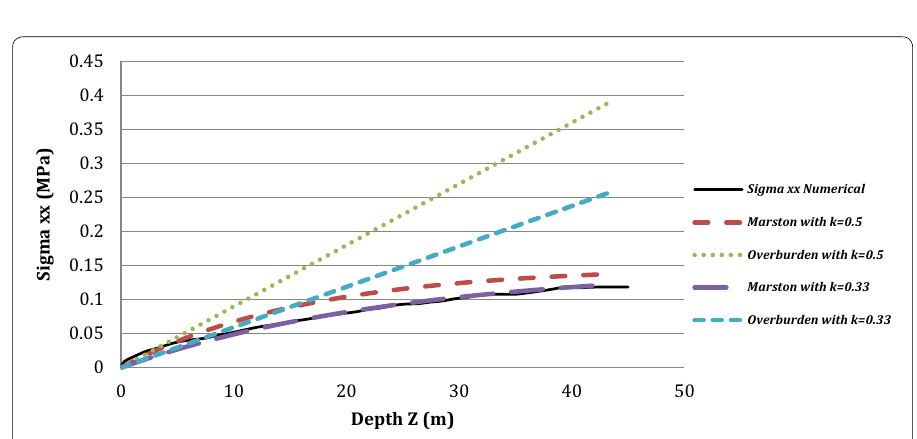
Fig. 5 Sigma xx (σ hz ) obtained from the analytical models and from the numerical results for a stope measur- ing 6 45 ×